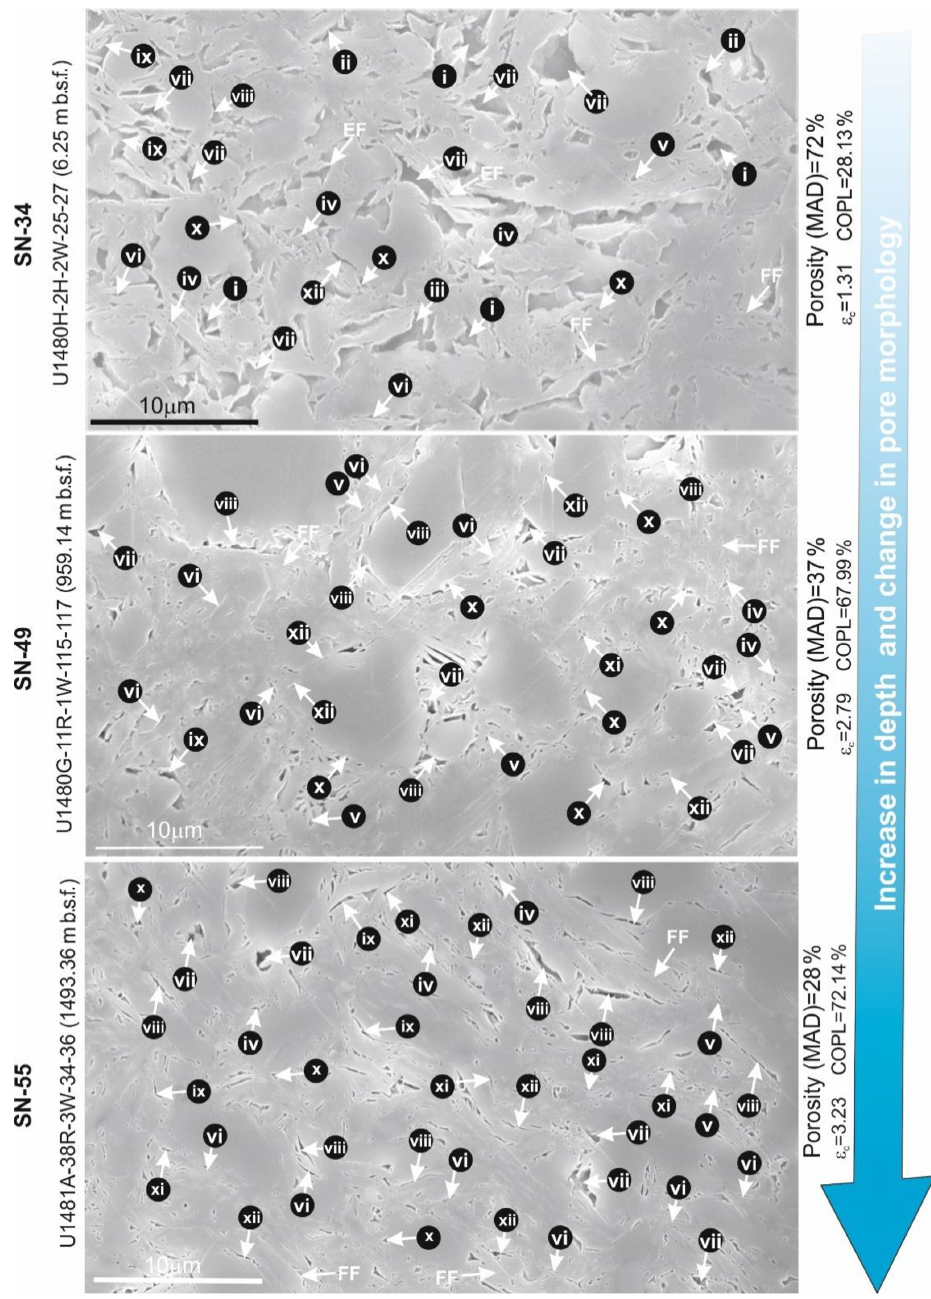
Figure 7. Microstructural overview (field-emission SEM) of samples SN-34, SN-49, and SN-55. (i) Equant large clay-domain pores, (ii) elon- gated large clay-domain pores, (iii) crescent-shaped large clay-domain pores, (iv) equant small clay-domain pores, (v) crescent-shaped small clay-domain pores, (vi) elongated small clay-domain pores, (vii) equant large silt-adjacent pores, (viii) elongated large silt-adjacent pores, (ix) crescent-shaped large silt-adjacent pores, (x) equant small silt-adjacent pores, (xi) crescent-shaped small silt-adjacent pores, (xii) elon- gated small silt-adjacent pores. FF: face-to-face contact, EF: edge-to-face contact.